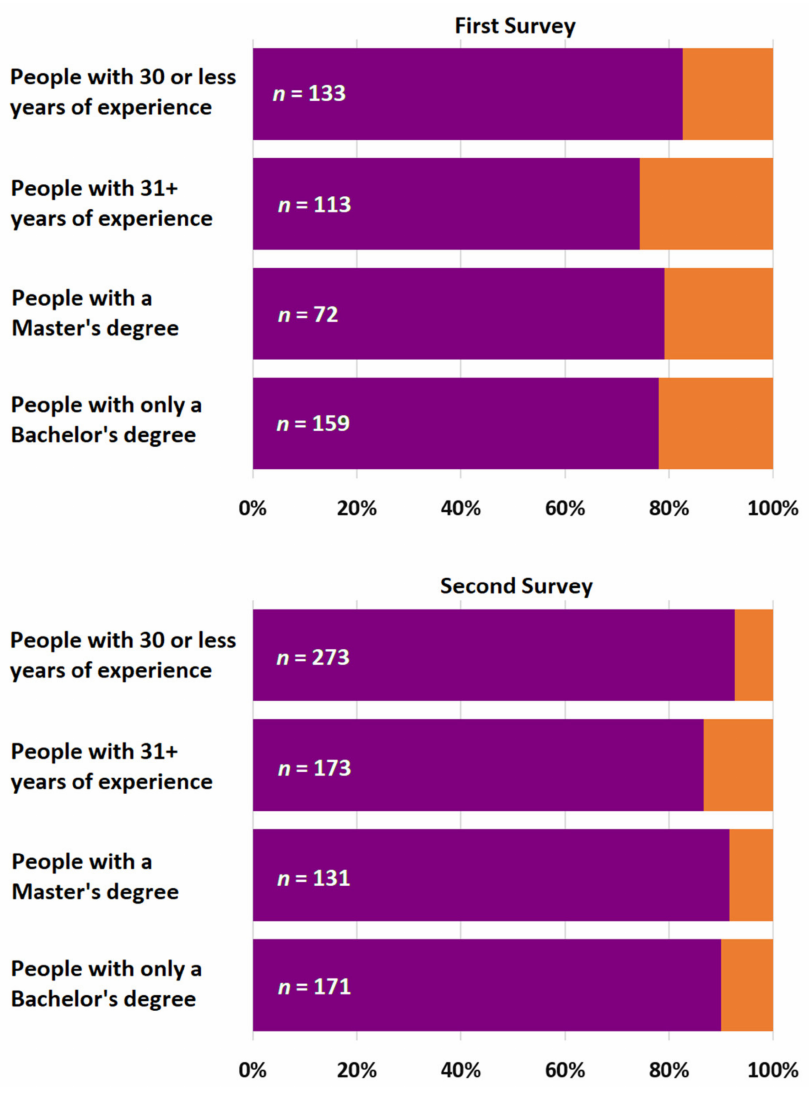
Figure 3. Percentage of respondents in different demographic groups who indicated maps needed to be updated (purple) or not (orange).